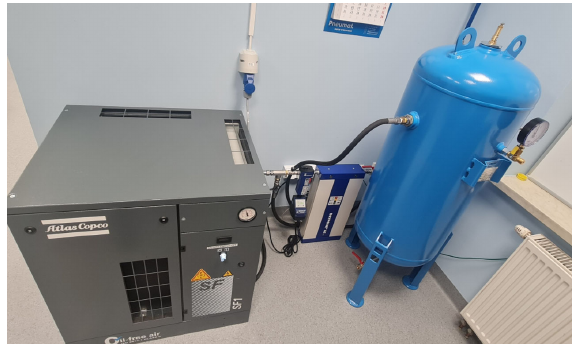
Figure 12. Photo of the Thermal Elephant Unit for scientific radiation imaging systems testing at AGH University of Science and Technology.